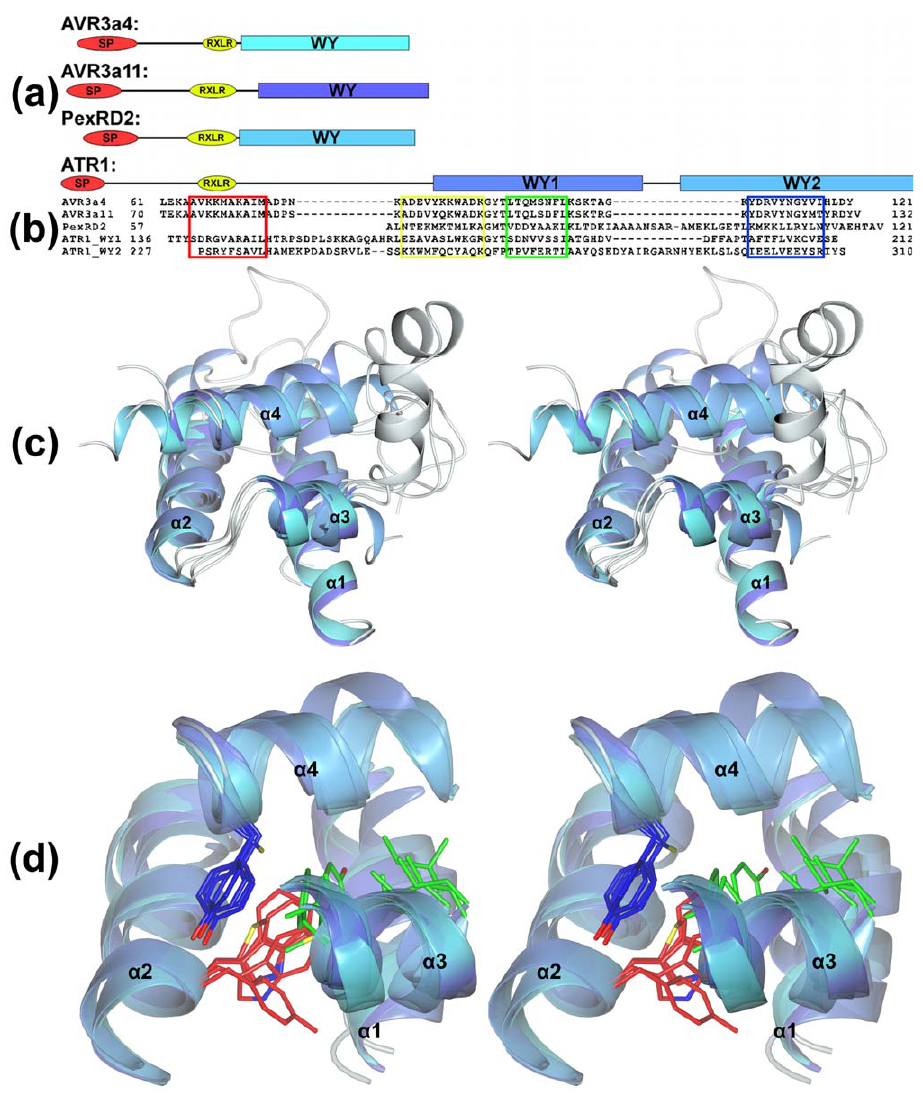
Figure 1. Structural conservation of the WY-domain fold in RXLR effectors from P. infestans , P. capsici , and H. arabidopsidis . (a) Schematic representation (to scale) of the domain architectures of AVR3a4, AVR3a11, PexRD2, and ATR1 showing the positions of the WY-domains used in the structural overlays. SP=signal peptide region, RXLR=RXLR/dEER region, WY=WY-domain regions (schematics are aligned at the end of the RXLR/dEER region). (b) Structure-based sequence alignment showing the positions of the conserved helices in each WY-domain. (c) Stereo view of an overlay comprising the WY-domains from AVR3a11, ATR1-WY1, ATR1-WY2, PexRD2, and AVR3a4 ( a 2– a 4 span the WY-domain, a 1 is the N- terminal helix present in all but PexRD2). The helices of the structures are colored in grades of blue through to cyan. Connecting regions are in gray (all structures). (d) Stereo view (orientation as in (c)) showing the positions of important residues within the hydrophobic core of the WY-domain (red=the W position, blue=the Y position, in green are two positions contributed from a 3). Only the conserved helices are shown in cartoon representation (connecting regions removed for clarity).